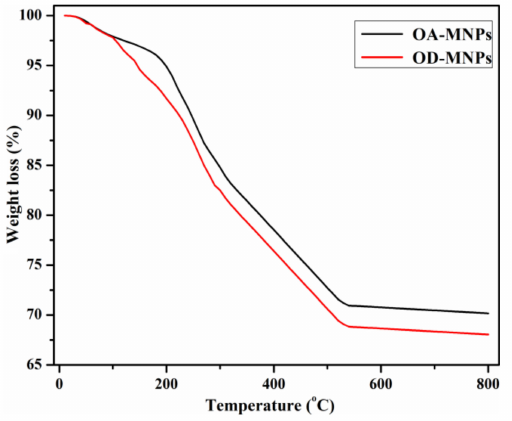
Figure 4. TGA thermograms of OA-MNPs and